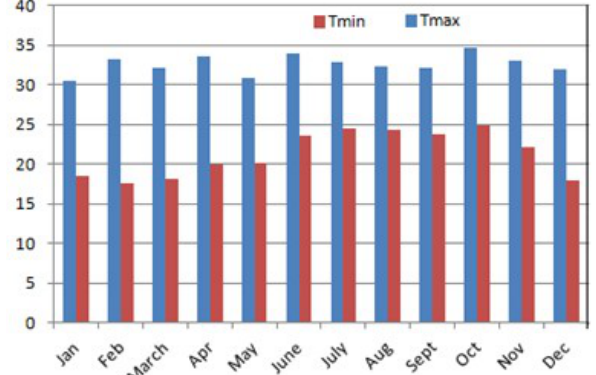
Figure 5: Annual variation of ambient maximal and minimal monthly temperatures of the Thies zone for years 2013, 2014 and 2014